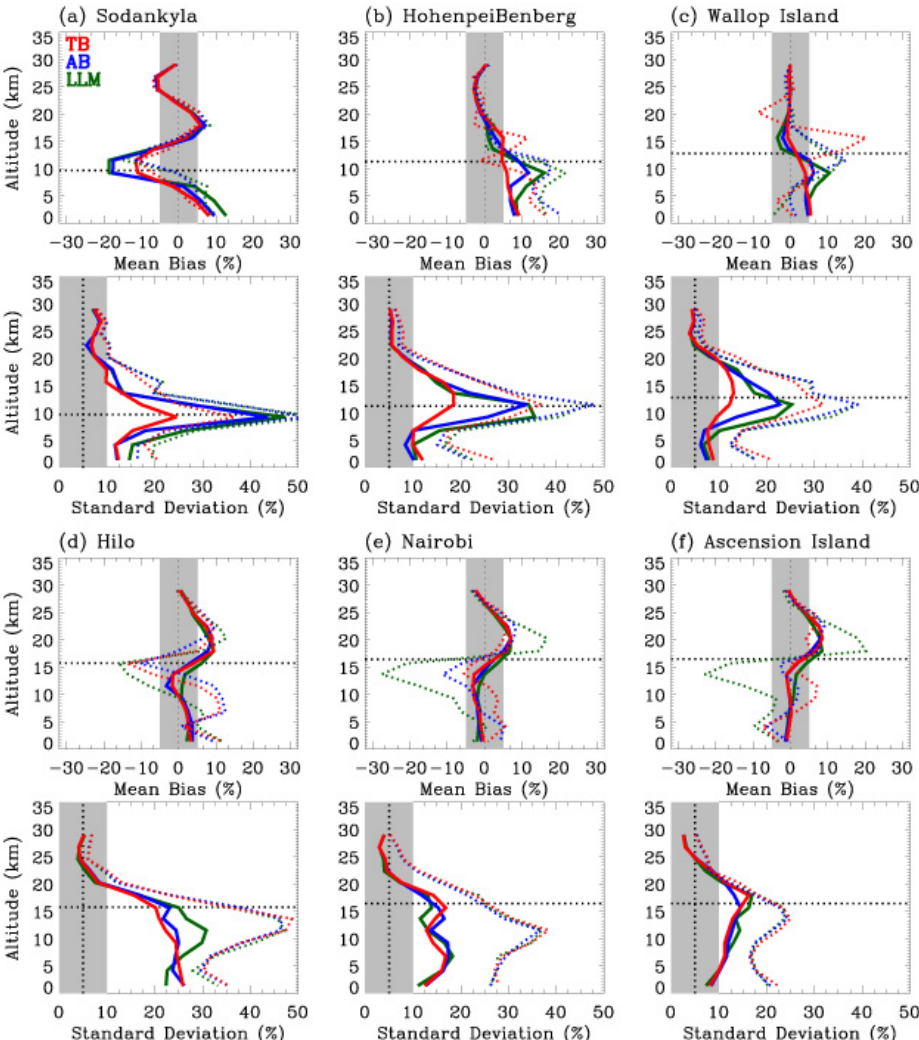
Fig. 8. Mean biases and 1 σ standard deviations of relative differences between OMI and ozonesonde profiles with (solid lines) and without (dotted lines) convolution using OMI averaging kernels from 2004 to 2008 at six stations, arranged by latitude. The relative difference is defined as 2(OMI − sonde)/(OMI + sonde) × 100. OMI ozone profiles are retrieved using TB (red line), AB (blue line), and LLM (green line) climatologies. The mean tropopause height is denoted with the horizontal dotted